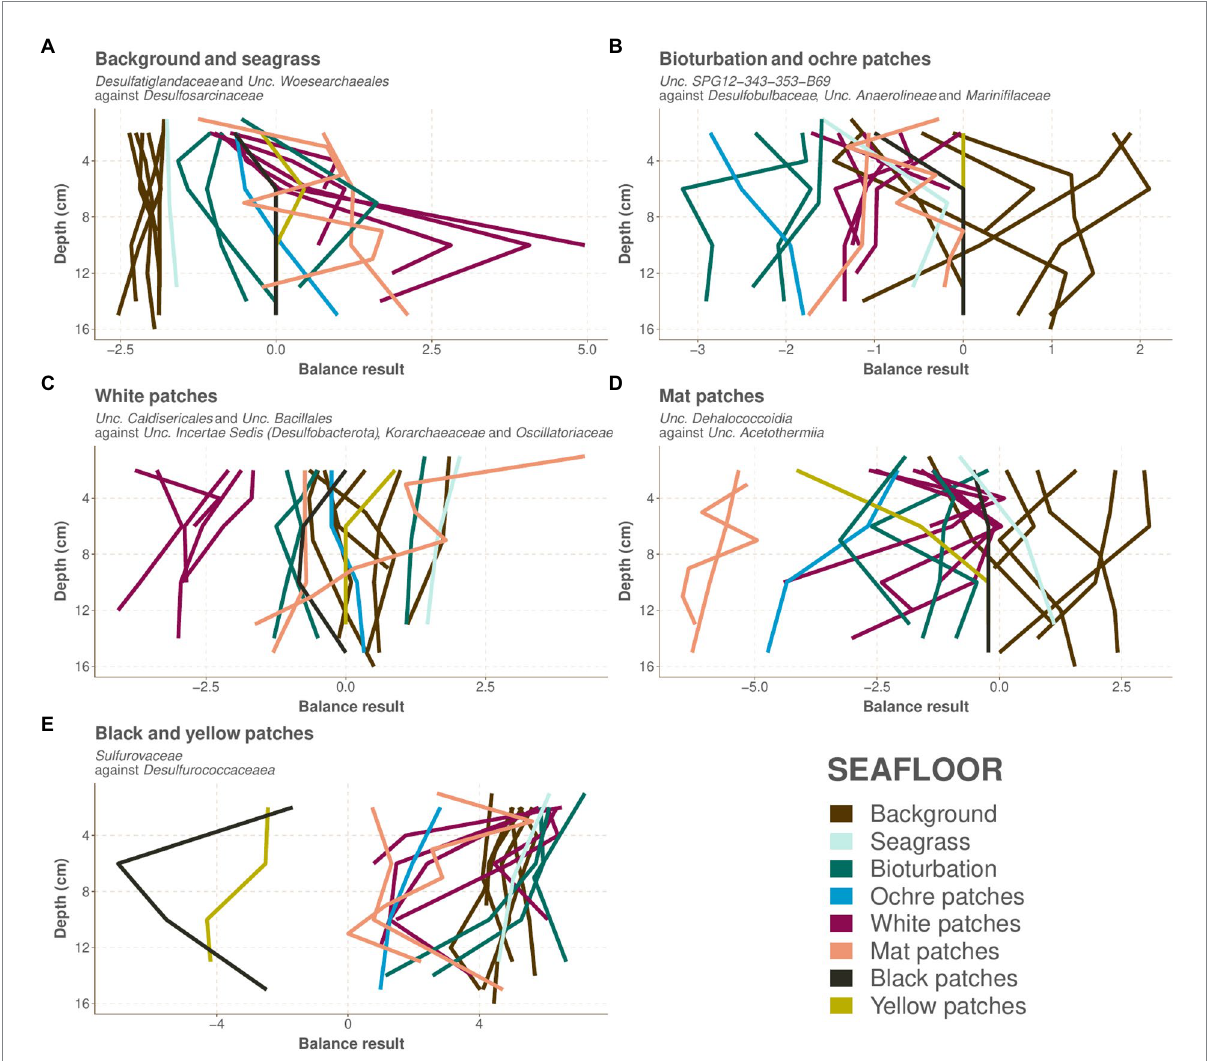
FIGURE 5 Values for the balances selected by the selbal algorithm for the separation of each group of seafloors. The values are plotted against depth, and each path represents one core, colored as in Figure 2. The color code for the seafloor types is as in Figure 1. (A) Background and seagrass, (B) bioturbation and ochre patches, (C) white patches, (D) mat patches, (E) black and yellow